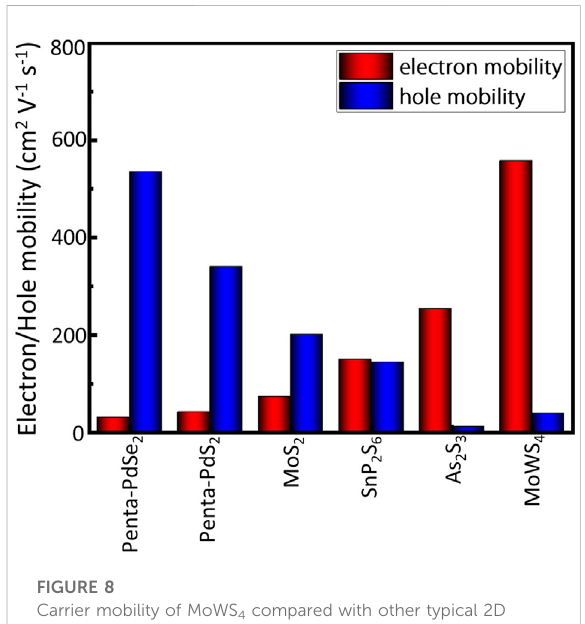
FIGURE 8 Carrier mobility of MoWS 4 compared with other typical 2D